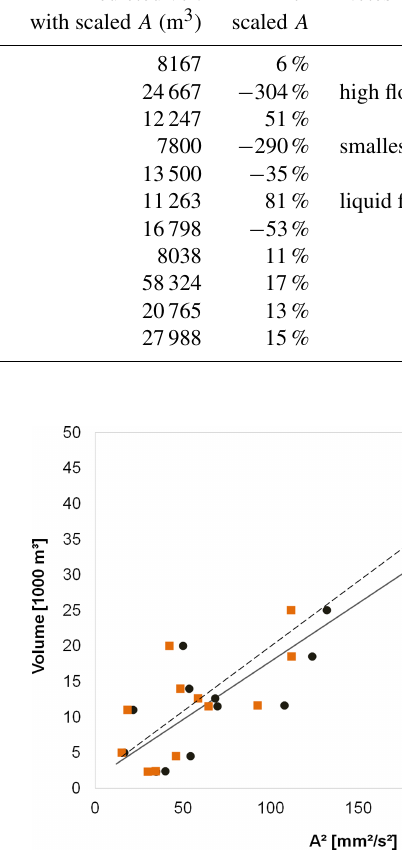
Figure 8. Comparison of the relationship between debris flow vol- umes vs. scaled and non-scaled seismic